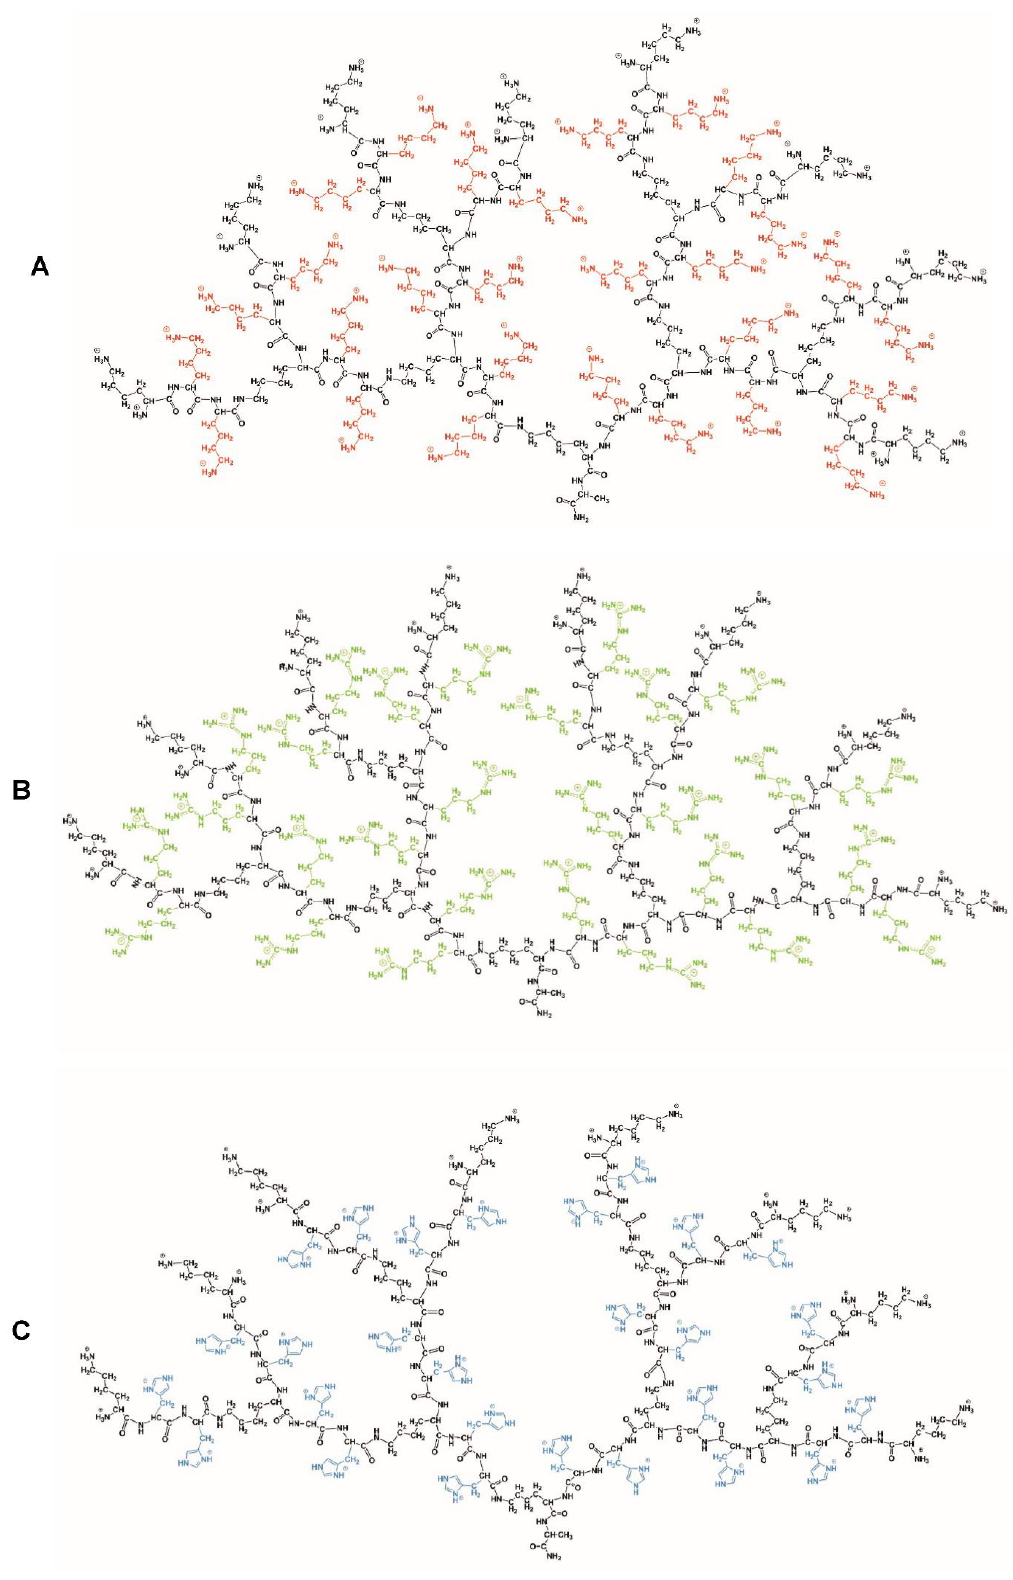
Figure 4. Dendrimer consisting of p( L -Lys) ( A ), and augmented with L- arginine ( B ) and L- histidine (C). The inclusion of amino acids other than L-lysine influences the zeta potential of the construct, and the cytotoxicity decreases with decreasing zeta potential; reproduced from Gorzkiewicz et al.